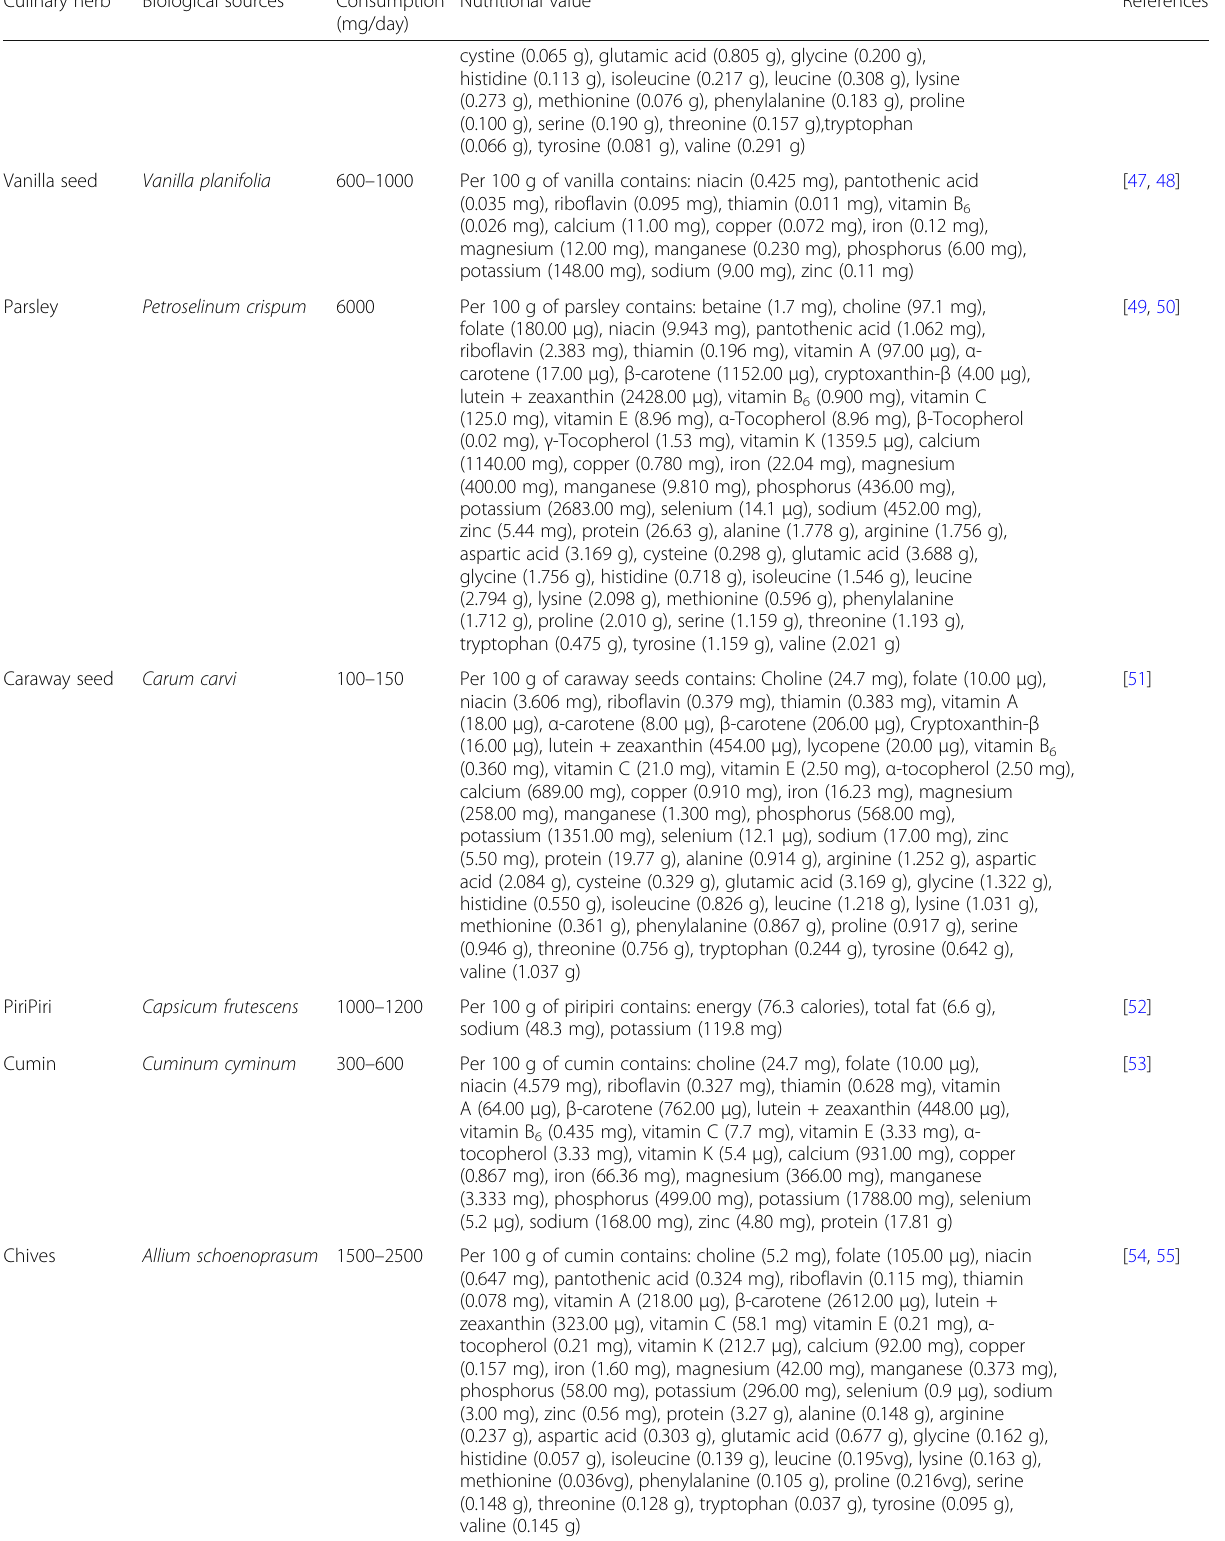
Table 2 Culinary herbs and spices in daily use